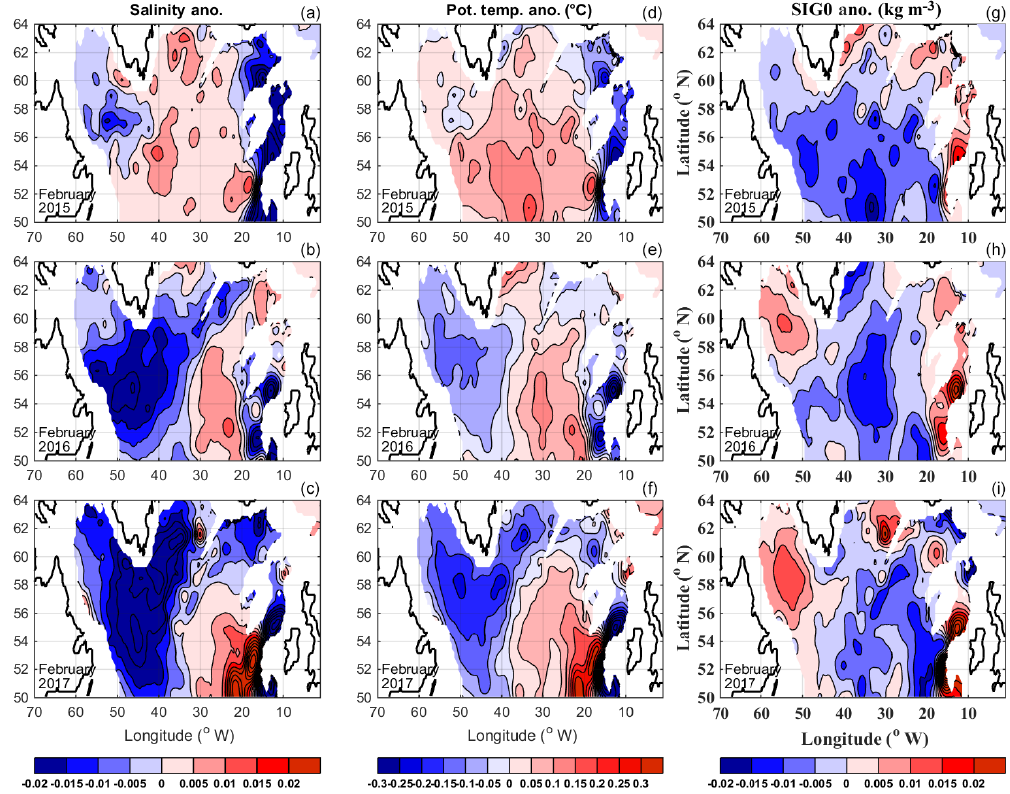
Figure 9. Horizontal distribution of the anomalies of S (a, b, c) , θ (d, e, f) and σ 0 (g, h, i) in the layer 1200–1400m in February 2015 (a, d, g) , February 2016 (b, e, h) and February 2017 (c, f, i) . The monthly anomalies were estimated from the ISAS database and were referenced to the period